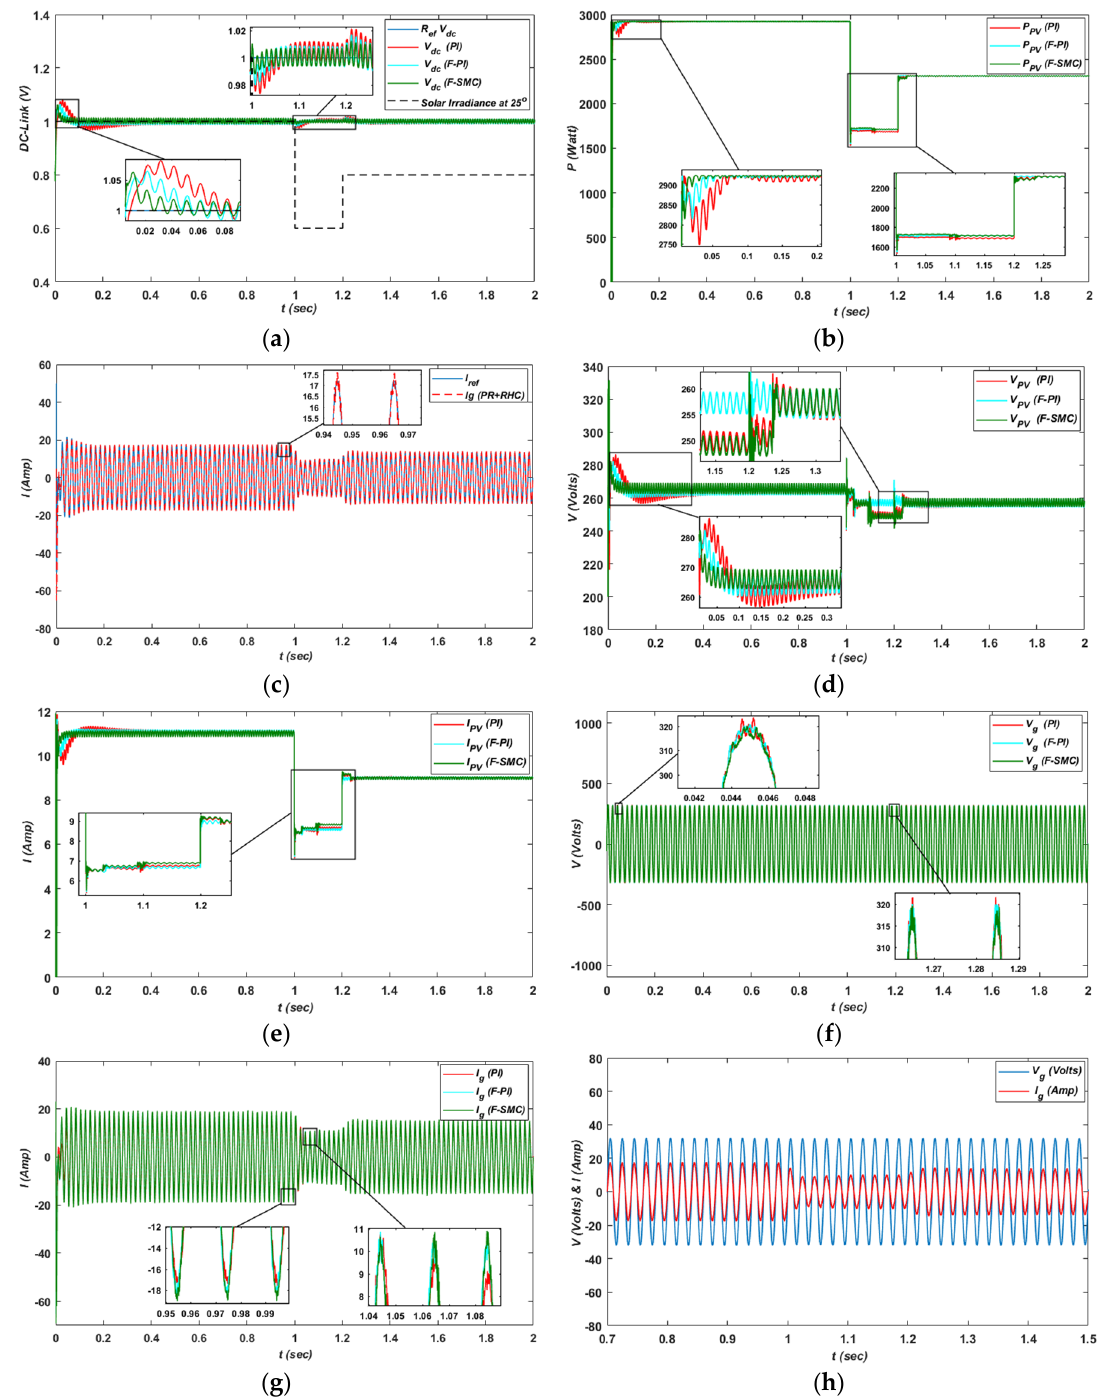
Figure 10. ( a ) DC-link voltage and SI using PI, F-PI, and F-SMC; ( b ) PV panels power using PI, F-PI, and F-SMC; ( c ) the proportional resonant controller with RHC for current loop; ( d ) PV panels voltages using PI, F-PI, and F-SMC; ( e ) PV panels currents using PI, F-PI, and F-SMC; ( f ) grid voltages using PI, F-PI, and F-SMC; ( g ) grid currents using PI, F-PI, and F-SMC; ( h ) response of grid voltage and grid current.